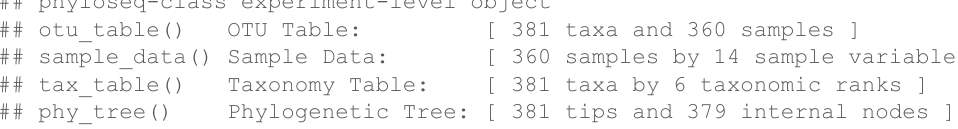
[ 381 taxa by 6 taxonomic ranks ] Phylogenetic Tree: [ 381 tips and 379 internal nodes